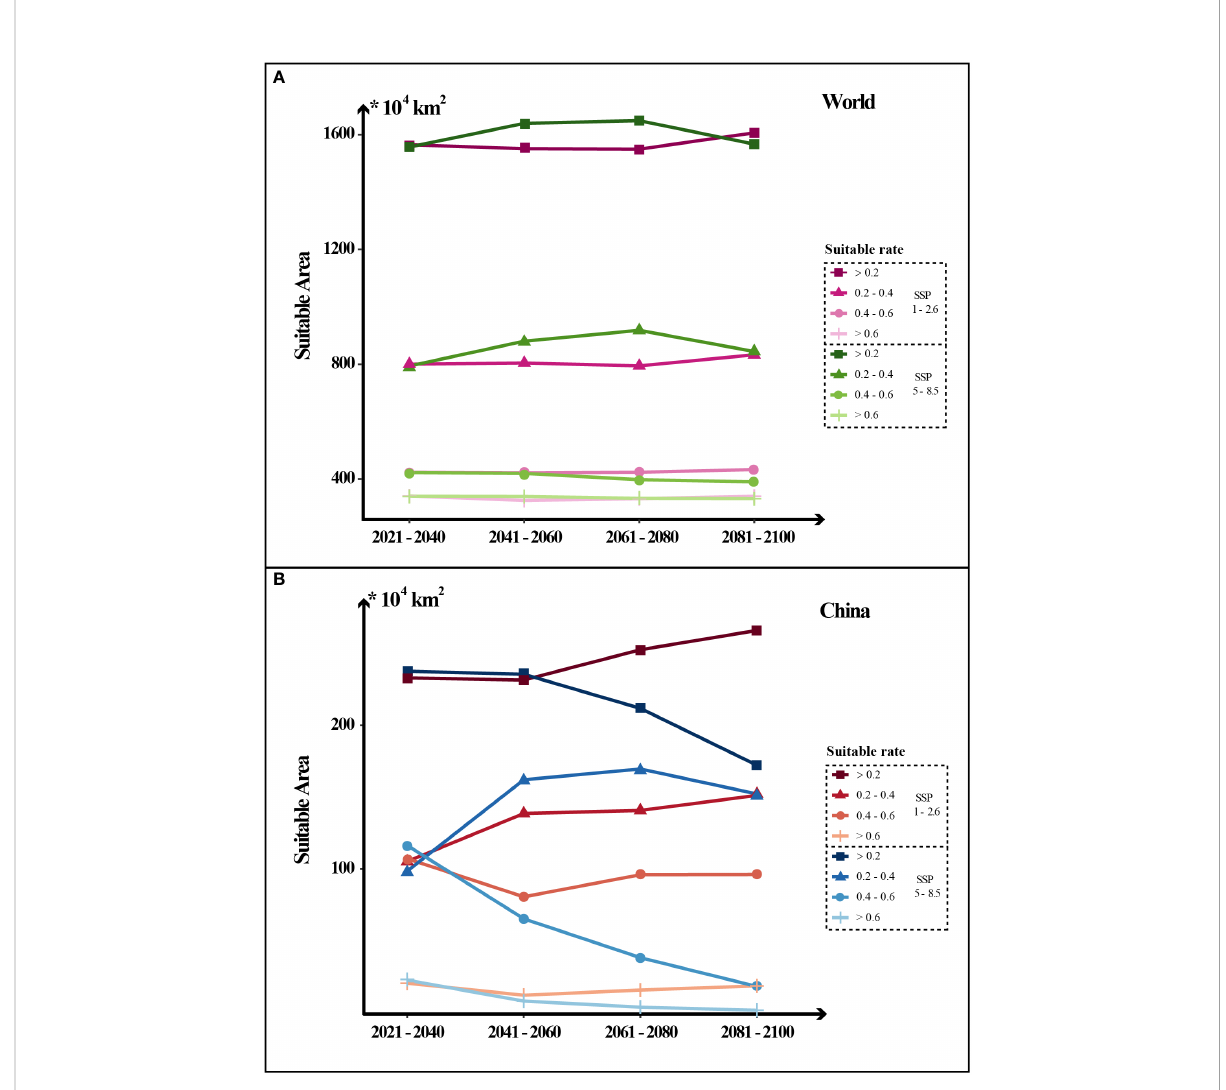
FIGURE 5 Dynamic changes in the area of potential Coptis suitable distribution in the world and China in the future four periods under two greenhouse gas emission scenarios (SSP126 and SSP585). The levels of suitability are shown in different line types: low suitability (0.2-0.4); medium suitability (0.4-0.6); high suitability (0.6-1) and total suitability (> 0.2, the sum of high, medium and low